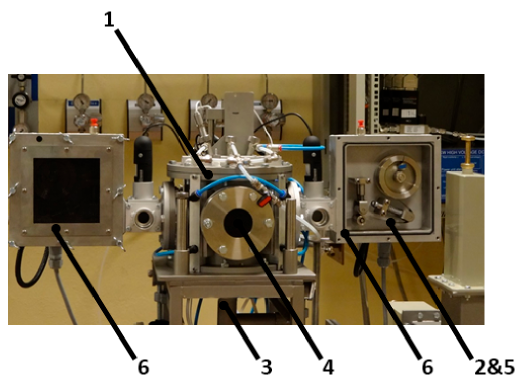
Figure 7. Photo of the plasma processing system where: 1—reactor chamber; 2—substrate ‐ metal strip; 3—microwave plasma head; 4—microwave plasma torch (not visible); 5—CNTs (not visible); 6—cassettes to move the metal substrate.